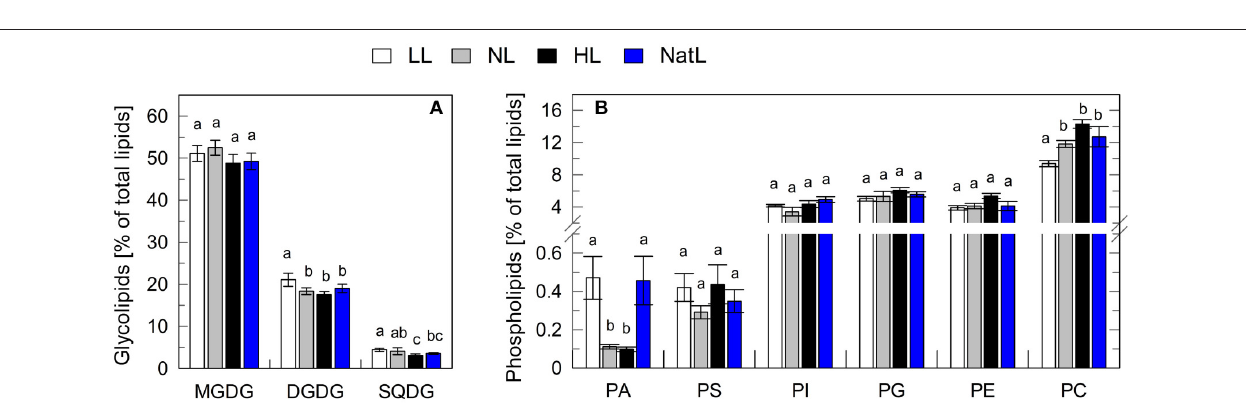
FIGURE 3 | Transmission electron microscopy analysis of chloroplasts. Upper panel: Electron microscopic images of the thylakoid membrane structure of (A) LL plants, (B) NL plants, (C) , HL plants, and (D) NatL plants. Round dark structures (arrow heads) represent plastoglobules. Lower panel: Quantification of (E) the width of grana stacks, (F) the number of membranes per grana stack and (G) the number of plastoglobules. Mean values ± SE of at least six images are shown. Significant differences (Dunn’s test, p < 0.05) are indicated.